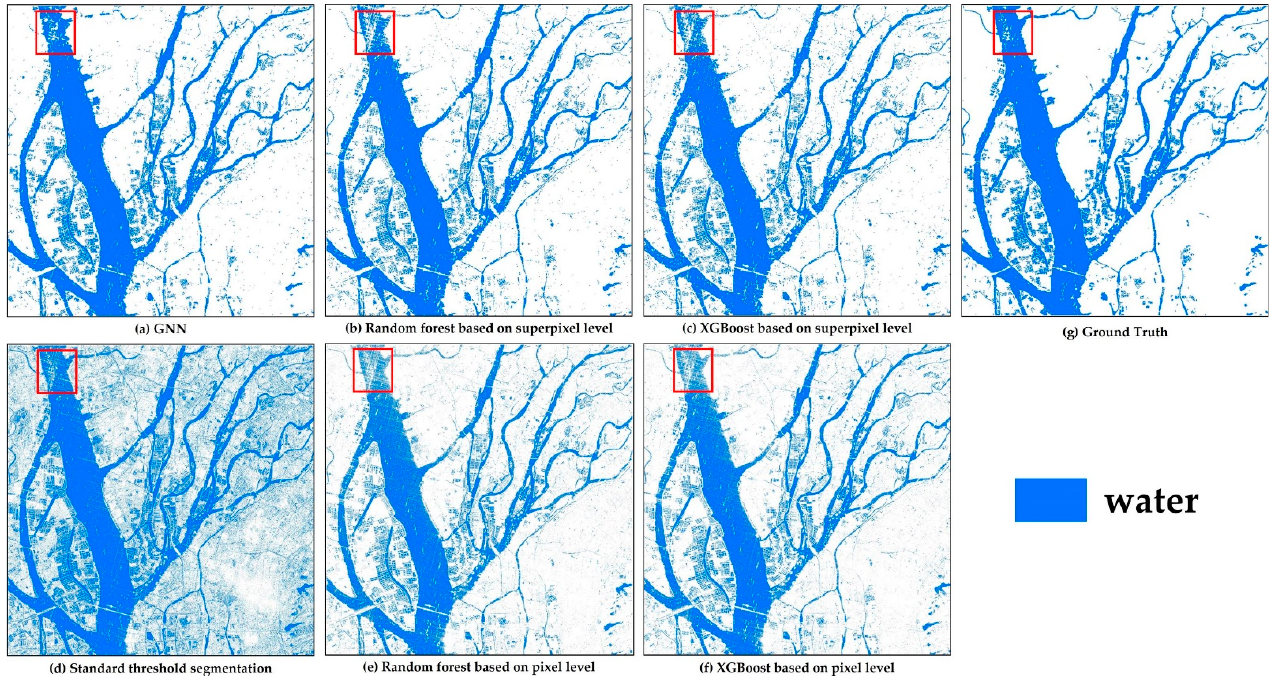
Figure 12. Study Area 2 classification results of ( a ) superpixel-based GNN, ( b ) superpixel-based RF, ( c ) superpixel-based XGBoost, ( d ) pixel-based Ostu, ( e ) pixel-based RF, and ( f ) pixel-based XGBoost. ( g ) shows the ground truth. The red box area shows GNN is better to cope with noise.